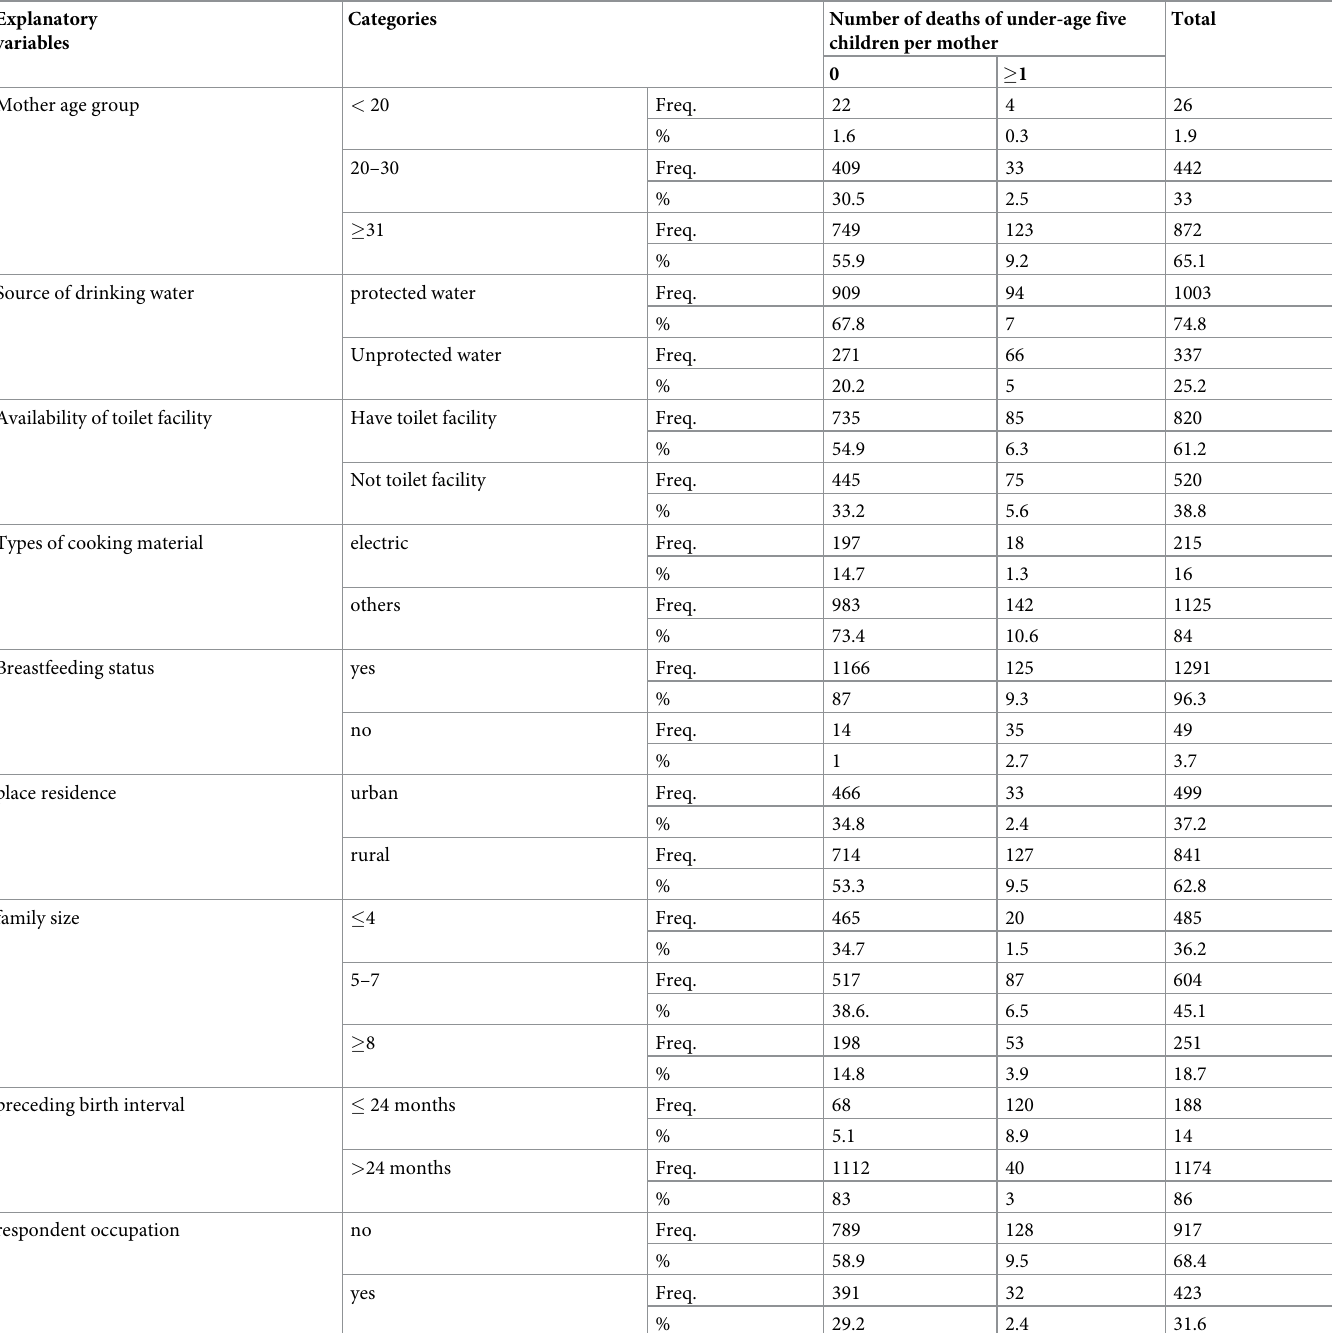
Table 2. Percentage and frequency of number of deaths of under-age five children per mother by explanatory variables. Explanatory